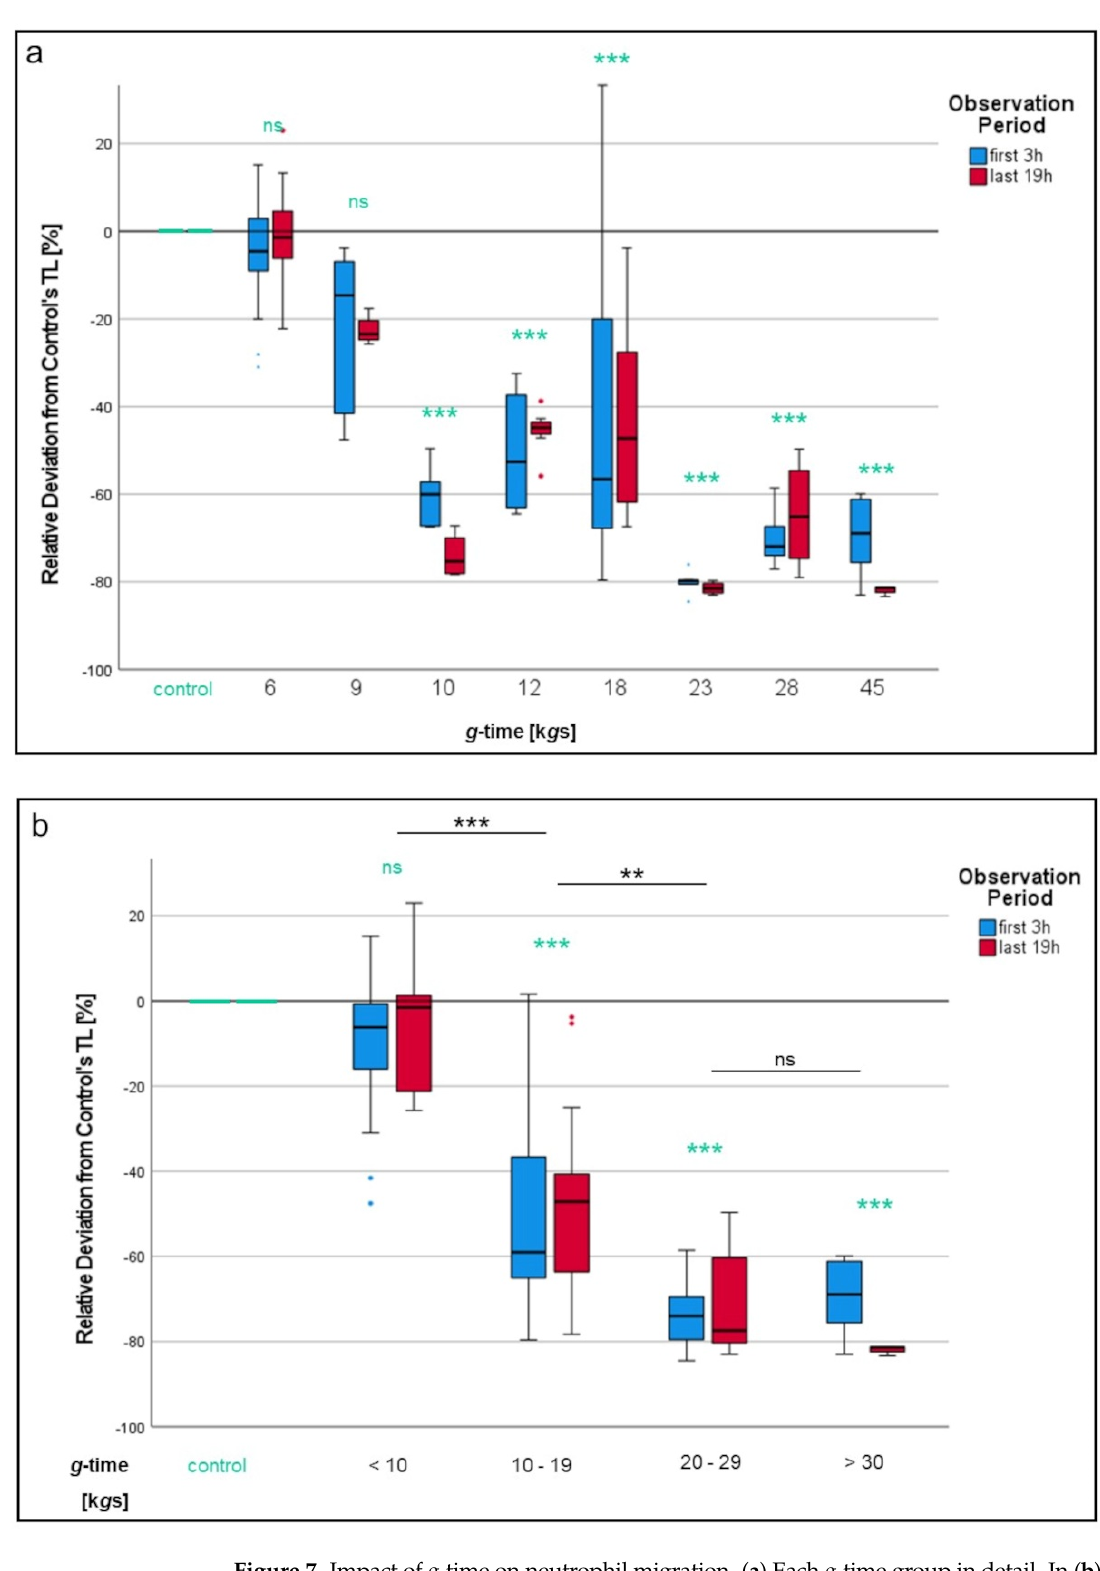
Figure 7. Impact of g -time on neutrophil migration. ( a ) Each g -time group in detail. In ( b ), groups are summarized into different g -time intervals. Significant differences compared to the 1 g control are turquoise colored. Significant differences between non-control samples are indicated with bars. Differences between analyzed groups in graphics are marked as: ns = not significant; ** p < 0.01; *** p <